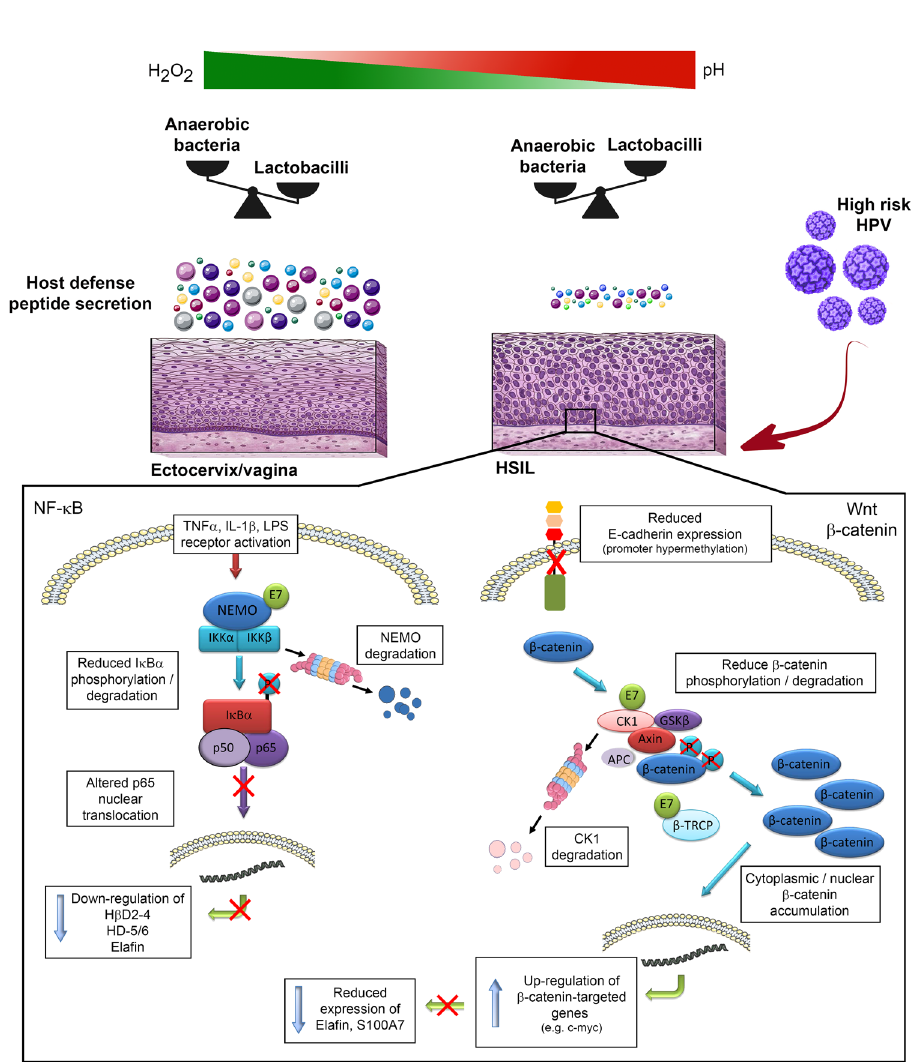
Fig. 8 Schematic representation of the proposed model. Left In HPV-positive cells, E7 oncoprotein impairs pro-in fl ammatory-induced innate peptide expression through inducing NEMO degradation and subsequent p65 cytoplasmic sequestration. Right In parallel, E7 reduces E-cadherin expression and alters β -catenin degradation complex by interacting with both CK1 and β -TrCP. As a result, defense peptides (e.g., ela fi n and S100A7) which are used by Lactobacillus species as amino acid source are greatly down-regulated by the β -catenin target gene c-myc. An imbalance in the vaginal fl ora is, therefore, achieved as a consequence of HPV persistence and subsequent immune evasion.